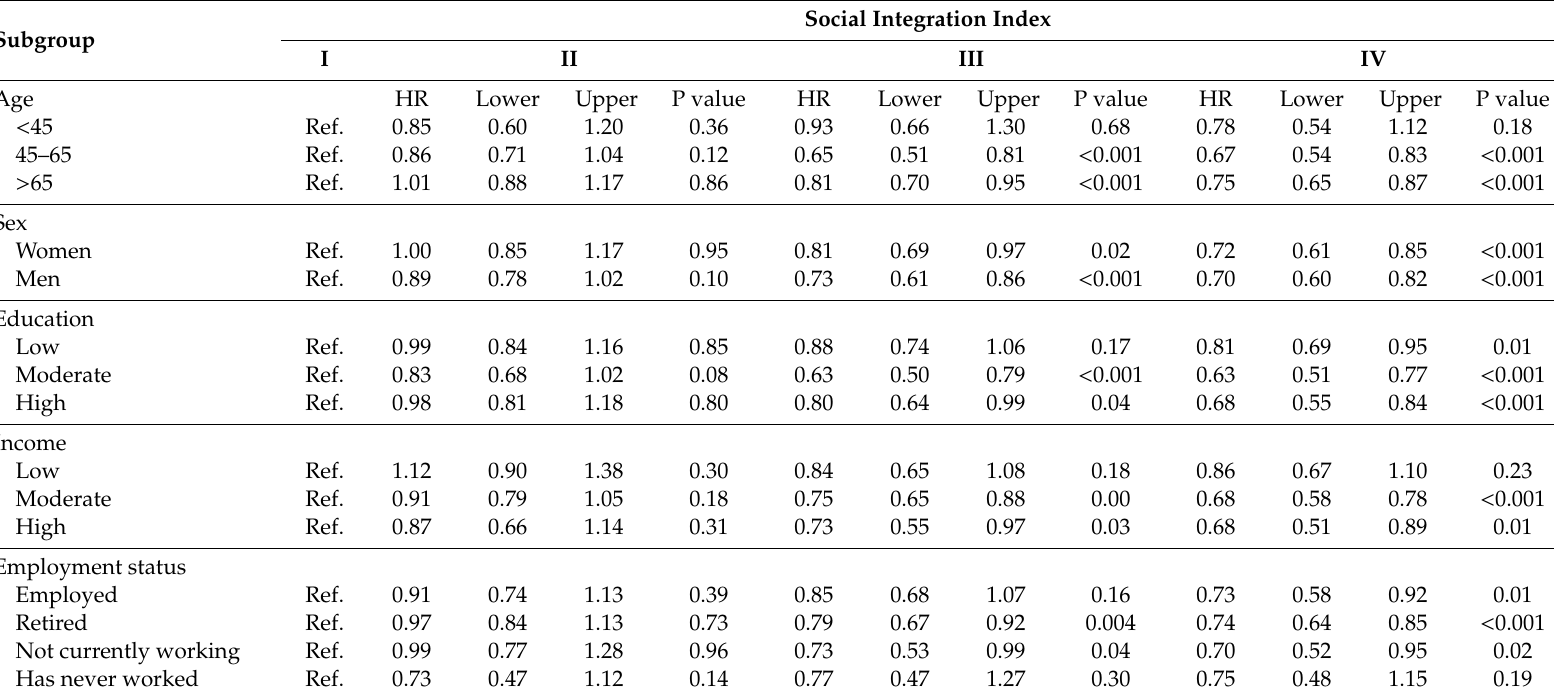
Table 5. Stratified analysis of all-cause mortality risk by social integration